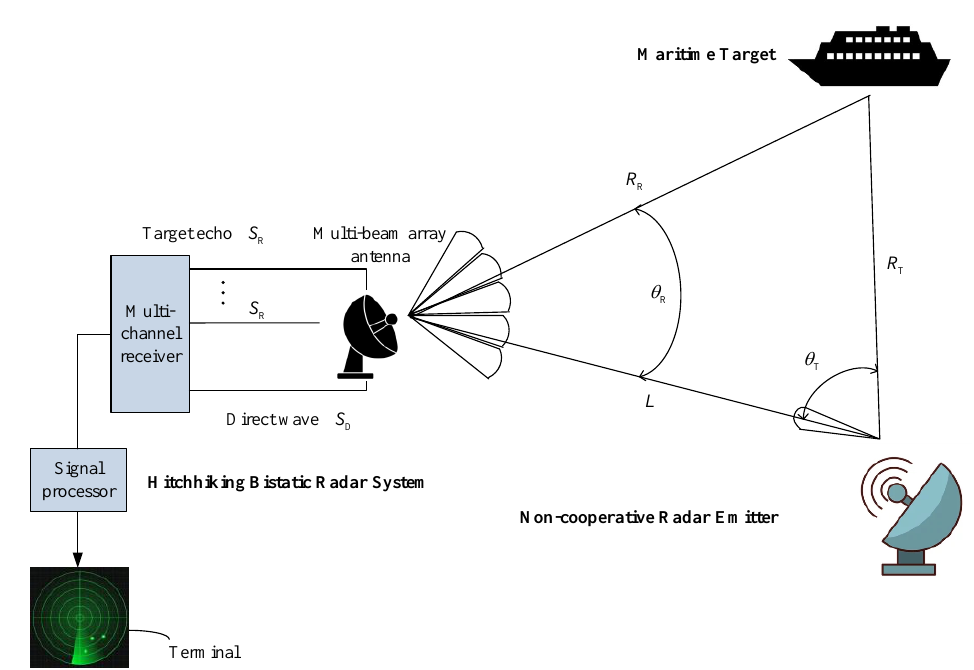
Figure 1. Typical hitchhiking bistatic radar (HBR) system.